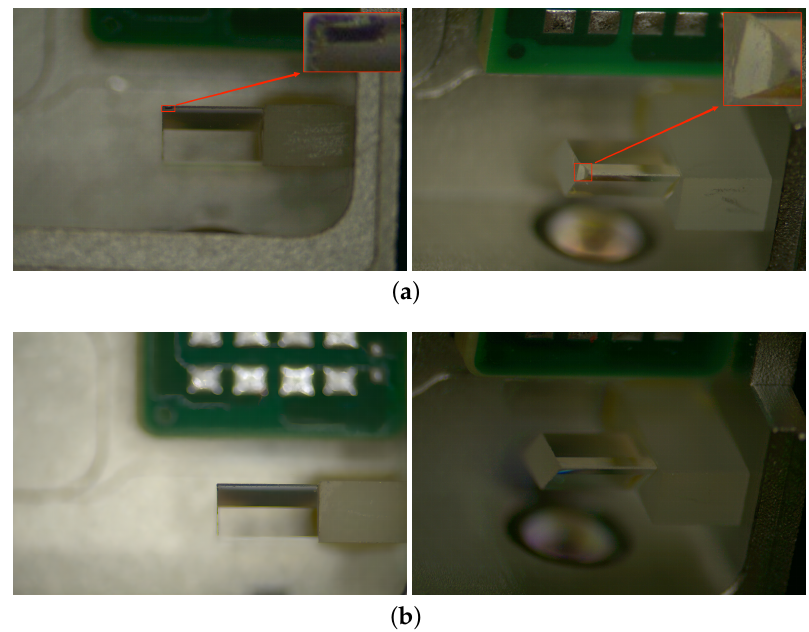
Figure 1. Optical glass images under different perspectives, the defect area is highlighted in the red box. ( a ) glass with defects; ( b ) glass without